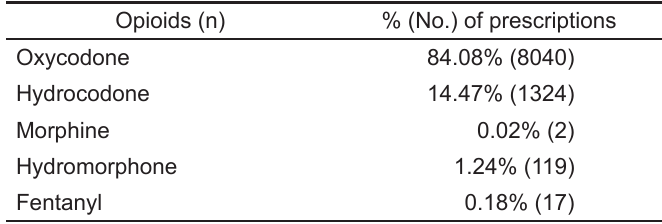
Table 1. Percentage of opioid prescriptions